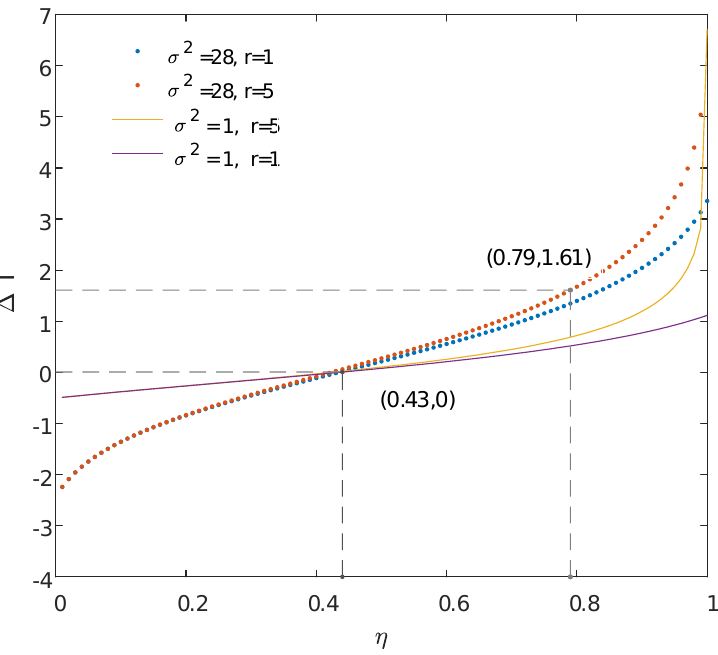
Figure 6. The information rate under attack ( Σ 2 = 1).